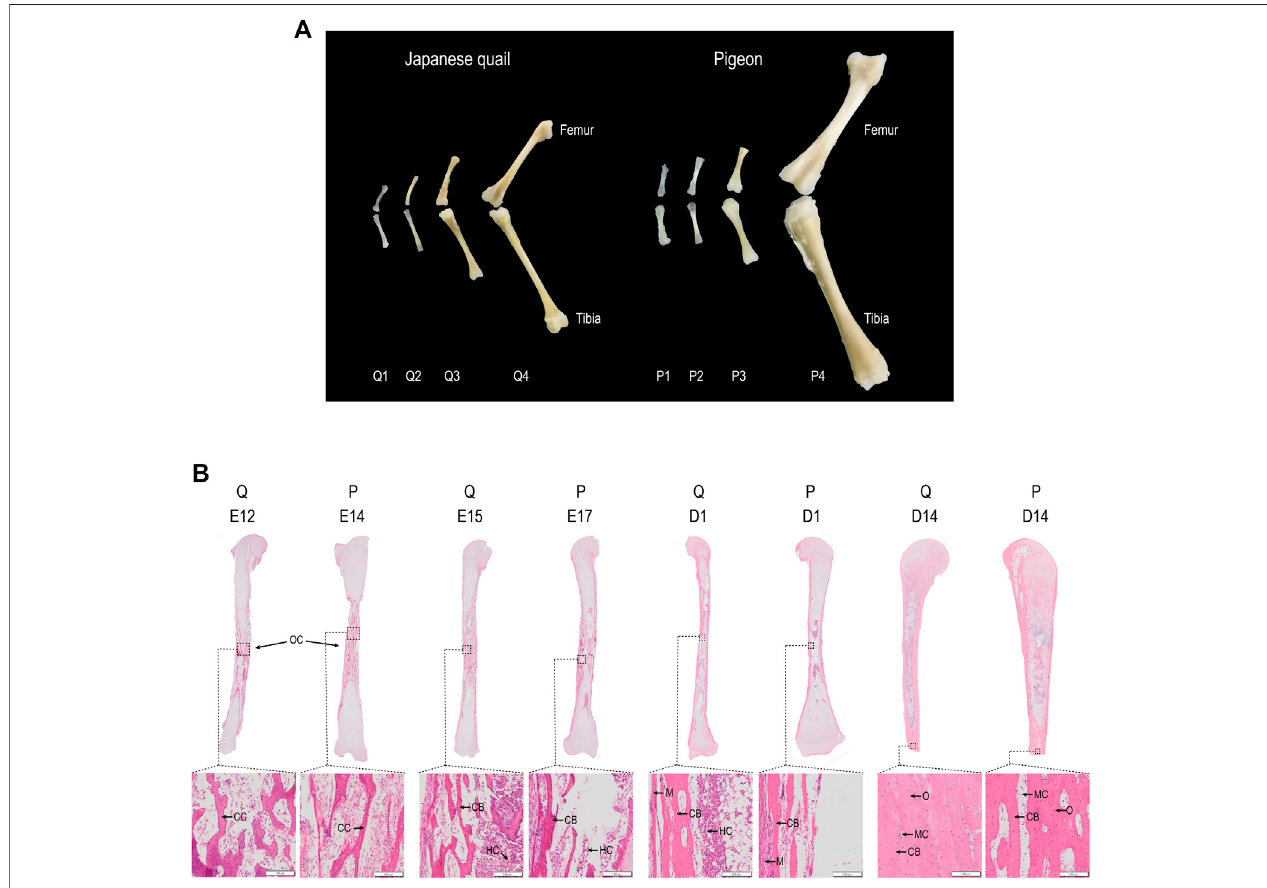
FIGURE 2 | Femur and tibia development of quail and pigeon before and post-hatching. (A) Comparison of femur and tibia morphology in four growth stages of quailandpigeon. (B) Comparisonoftibiapanoramicphotosinfourgrowthstagesofquailandpigeon.OC:ossi fi cationcenter;CC:calci fi edcartilage;HC:hematopoietic cells; CB: cortical bone; MC: marrow cavity; O: osteocyte; M: myocyte; Q: quail; P: pigeon.